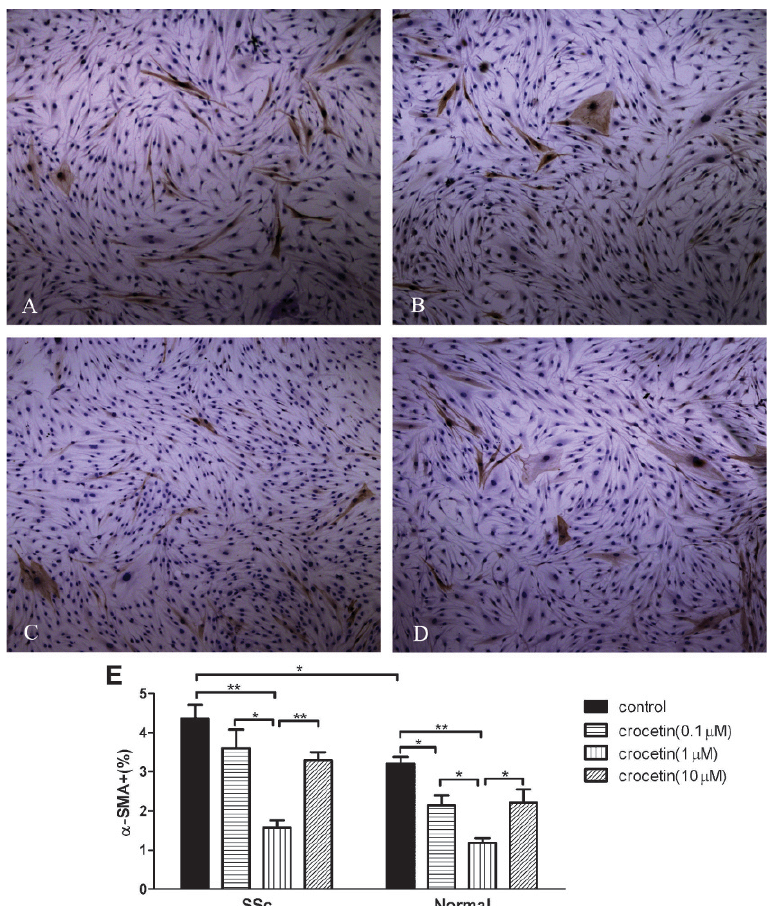
Figure 3 - Inhibitory effect of crocetin on the expression of a -smooth muscle actin ( a -SMA) in SSc and normal fibroblasts. (A-D) a -SMA expression in normal fibroblasts. Original magnification 6 100. ( a -SMA expression in SSc fibroblasts is not shown because the appearance is similar to normal cells). (E) a -SMA positive cells/total number of cells counted (%). * p , 0.05, ** p